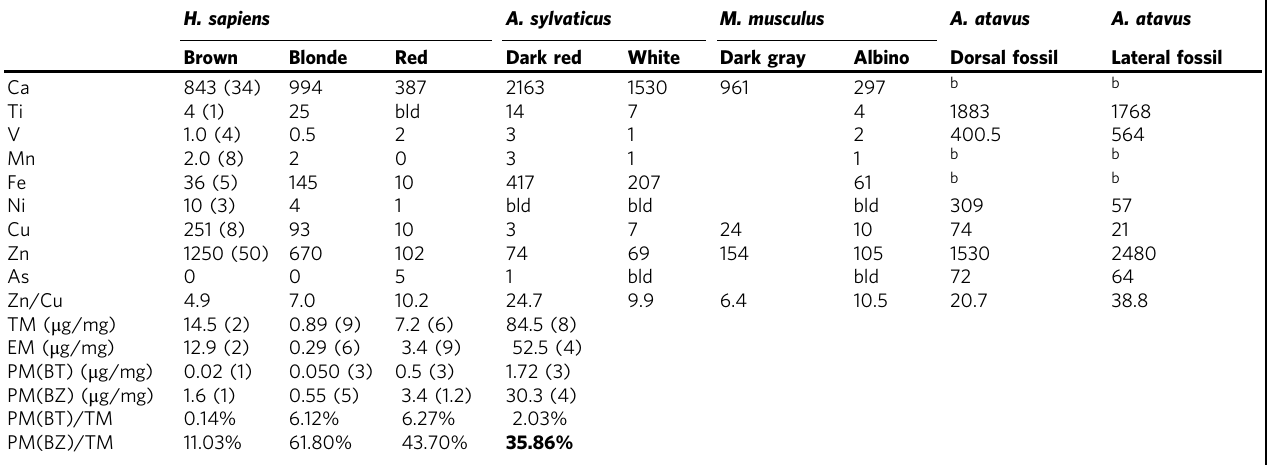
Table 2 XRF point analyses and melanin concentrations (units ppmW except where otherwise indicated a ) H. sapiens